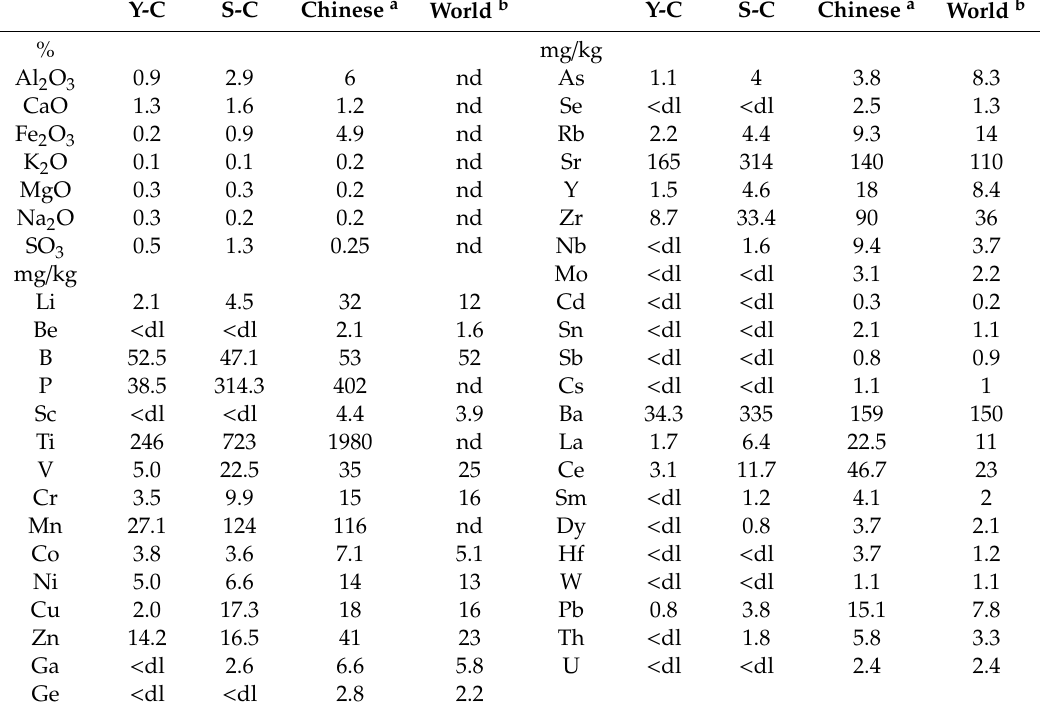
Table 2. Major oxide content (%) and trace element concentrations (mg/kg) of feed coals and corresponding values in Chinese and Worldwide coal. Y-C, feed coal from Yihua power plant; S-C, feed coal from Shenhuo power plant.